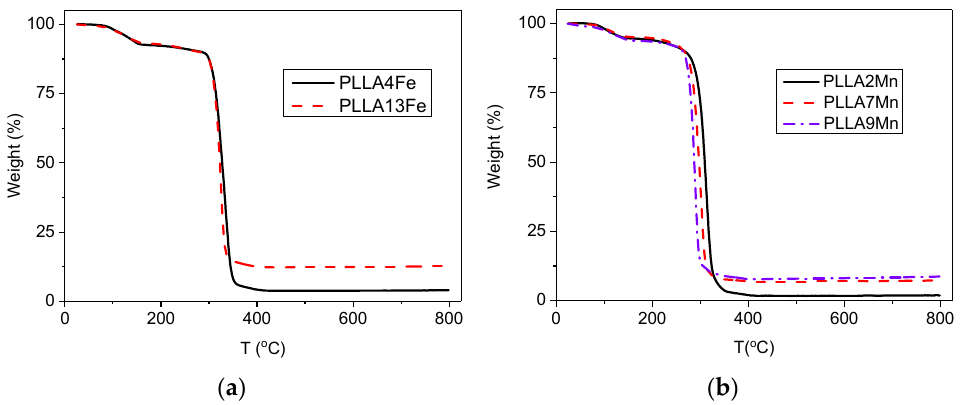
Figure 3. TG thermograms of ( a ) PLLA/ γ -Fe 2 O 3 and ( b ) PLLA/MnFe 2 O 3 composites. Table 1. MNPs concentration and Temperature of maximum weight loss rate, T p , of composites obtained from TGA results.